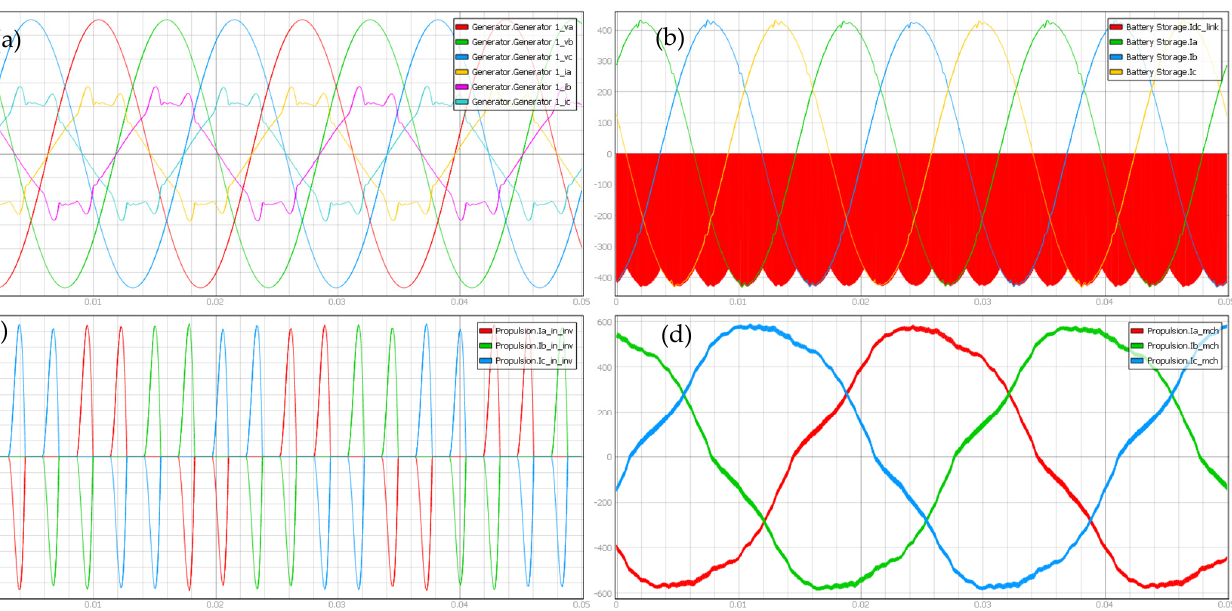
Figure 9. Results of case study 1/scenario C. From left to right, top to bottom: ( a ) diesel generator phase voltages and currents; ( b ) battery currents (at the battery itself and at the output of the filter); ( c ) input currents to the propulsion system; ( d ) stator currents of the induction motor.